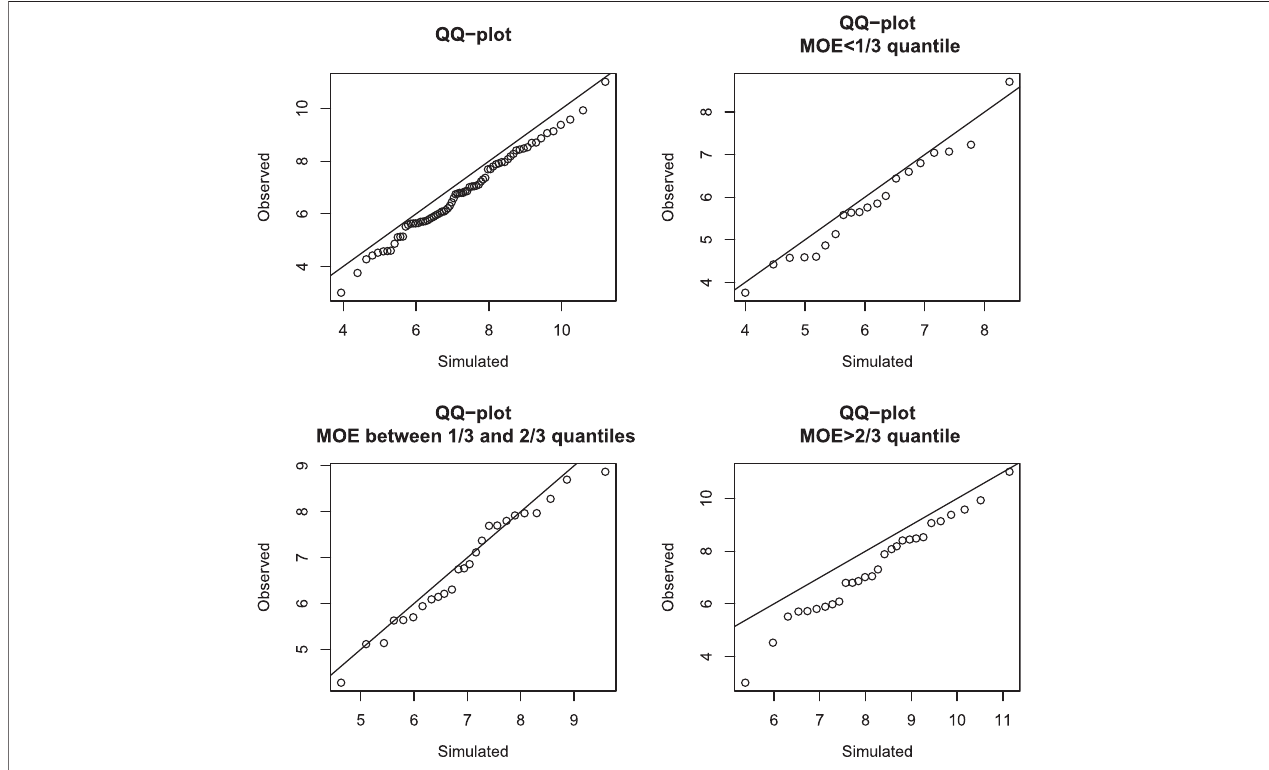
FIGURE 8 | Gaussian copula model and T20. Q-Q plot of observed residual MOR against simulated MOR with the identity line, given UTS greater than its 20 th quantile and MOE in different quantile intervals.